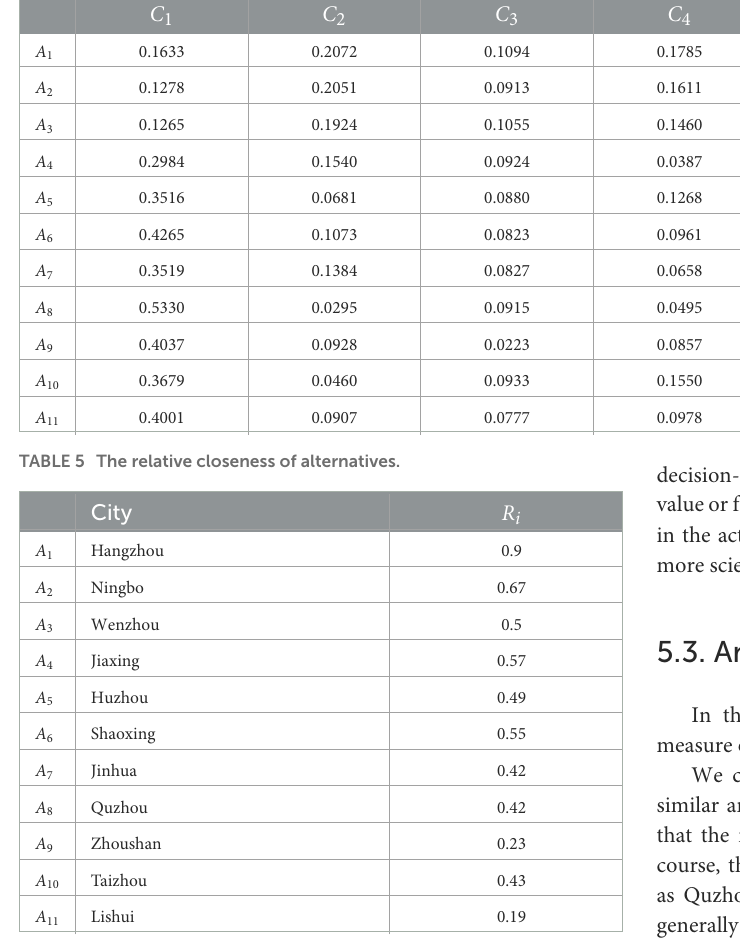
TABLE 4 Prospect theory weight of the worst reference point ω # .